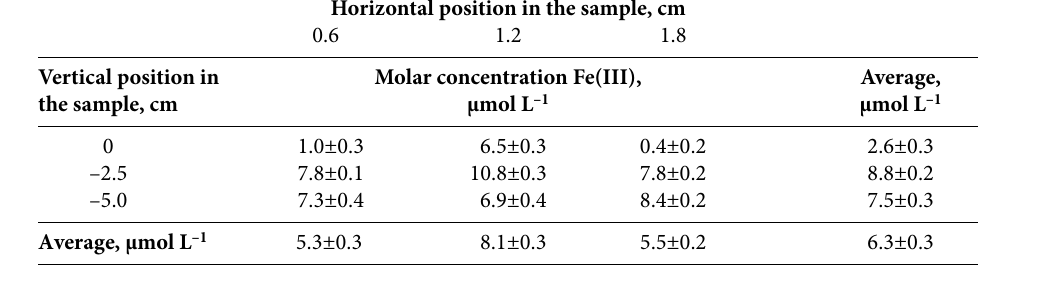
Table 3. Concentrations of the Fe (III) ions in the Chelex-100 resin.